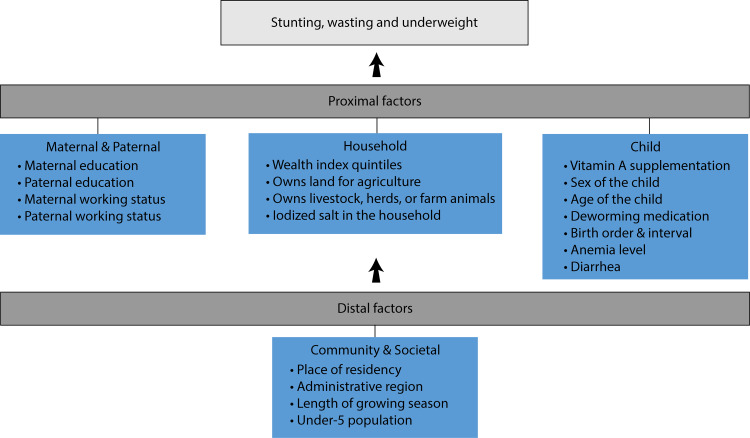
World health organization conceptual framework for the determinants of child undernutrition: Distal factors include community-level determinants, and proximal factors include child, household, maternal, and paternal-level determinants of undernutrition.